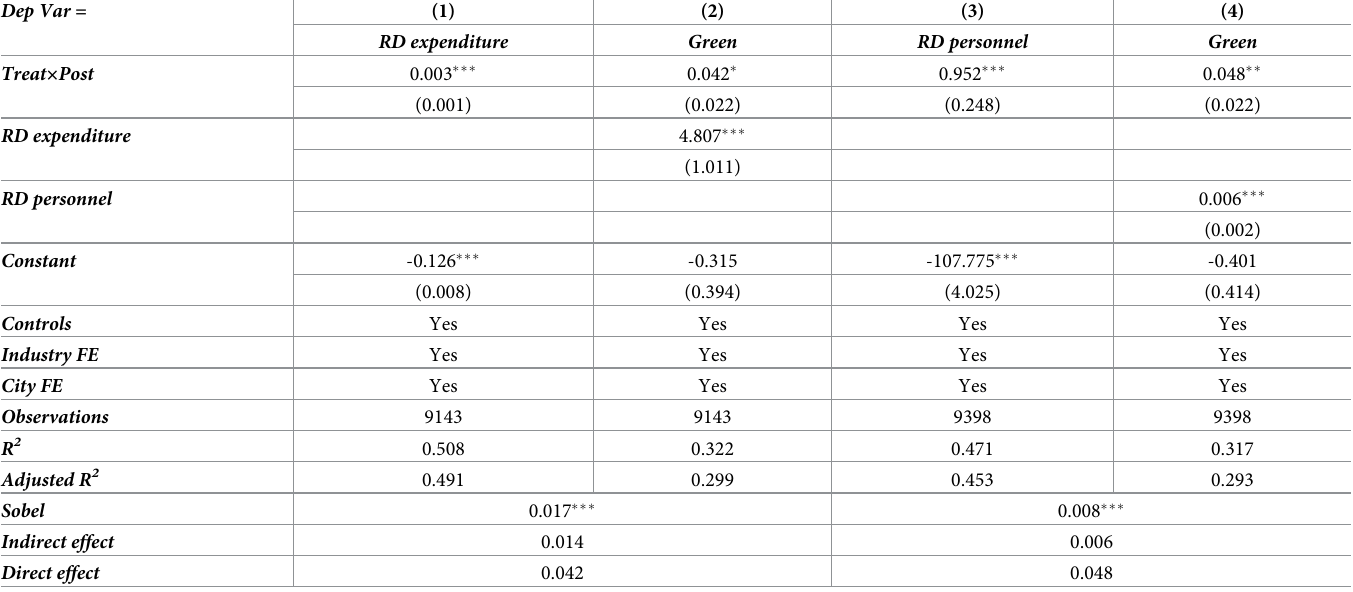
Table 7. R&D mechanism regression